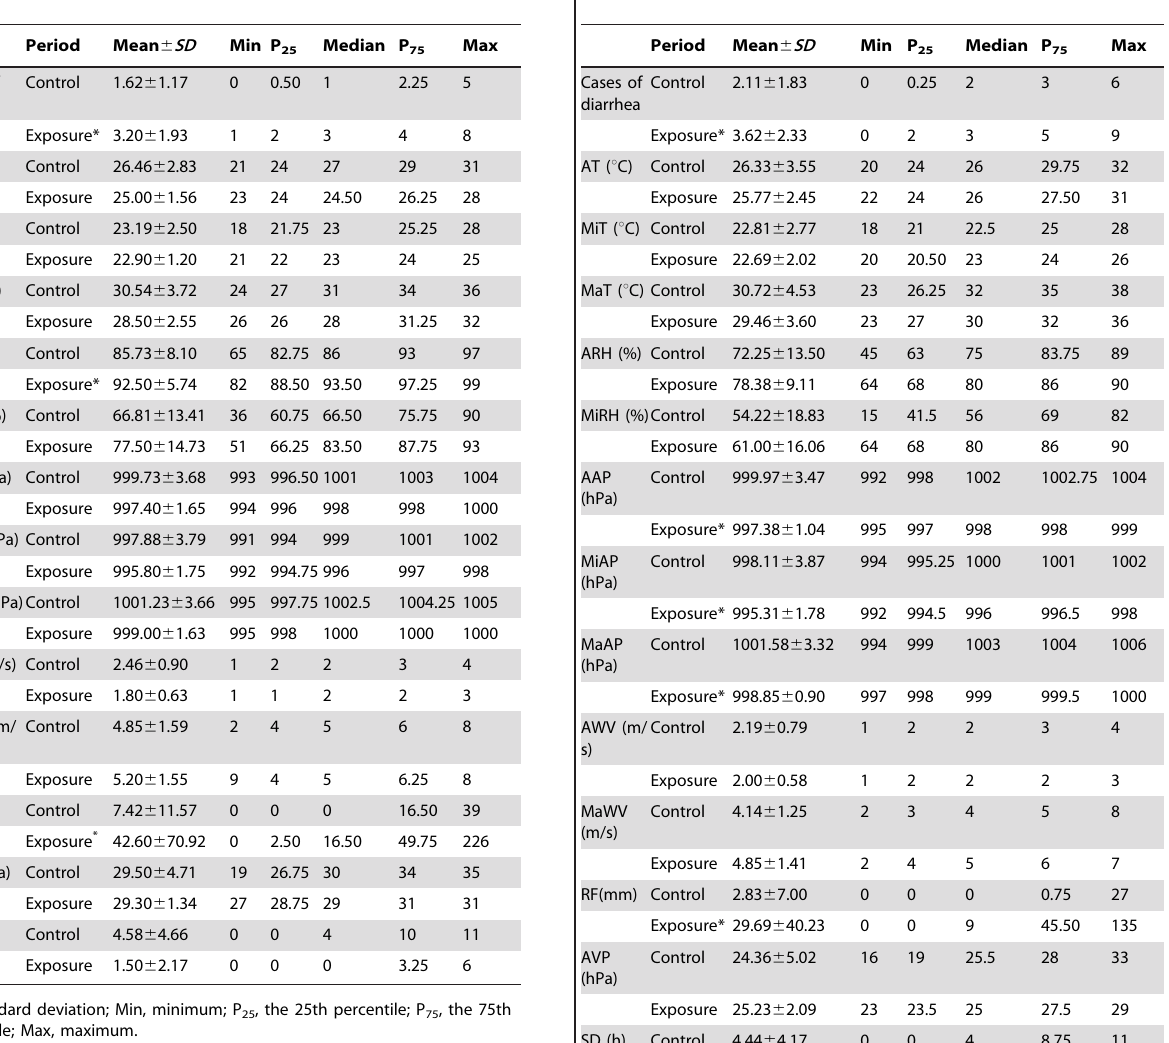
Table 1. Distribution of daily data on cases of infectious diarrhea and meteorological variables in Fuyang.